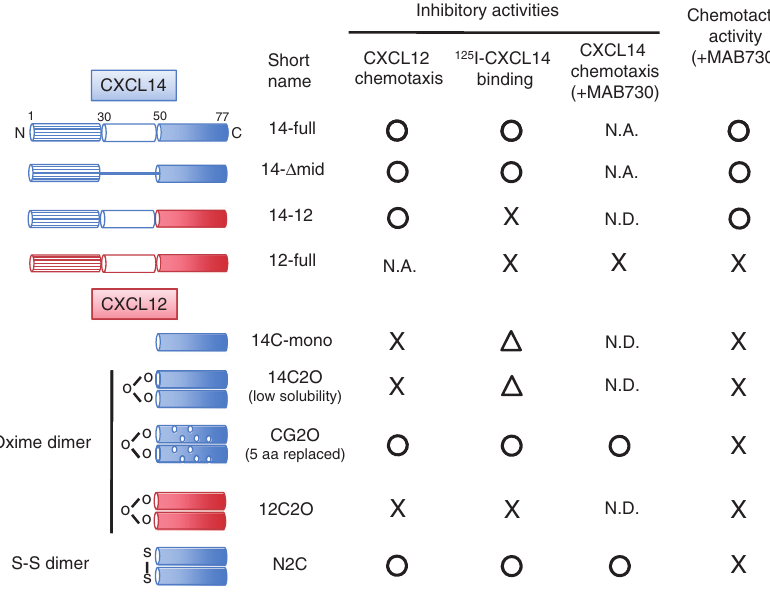
Figure 2 Structure-function relationship of the CXCL14